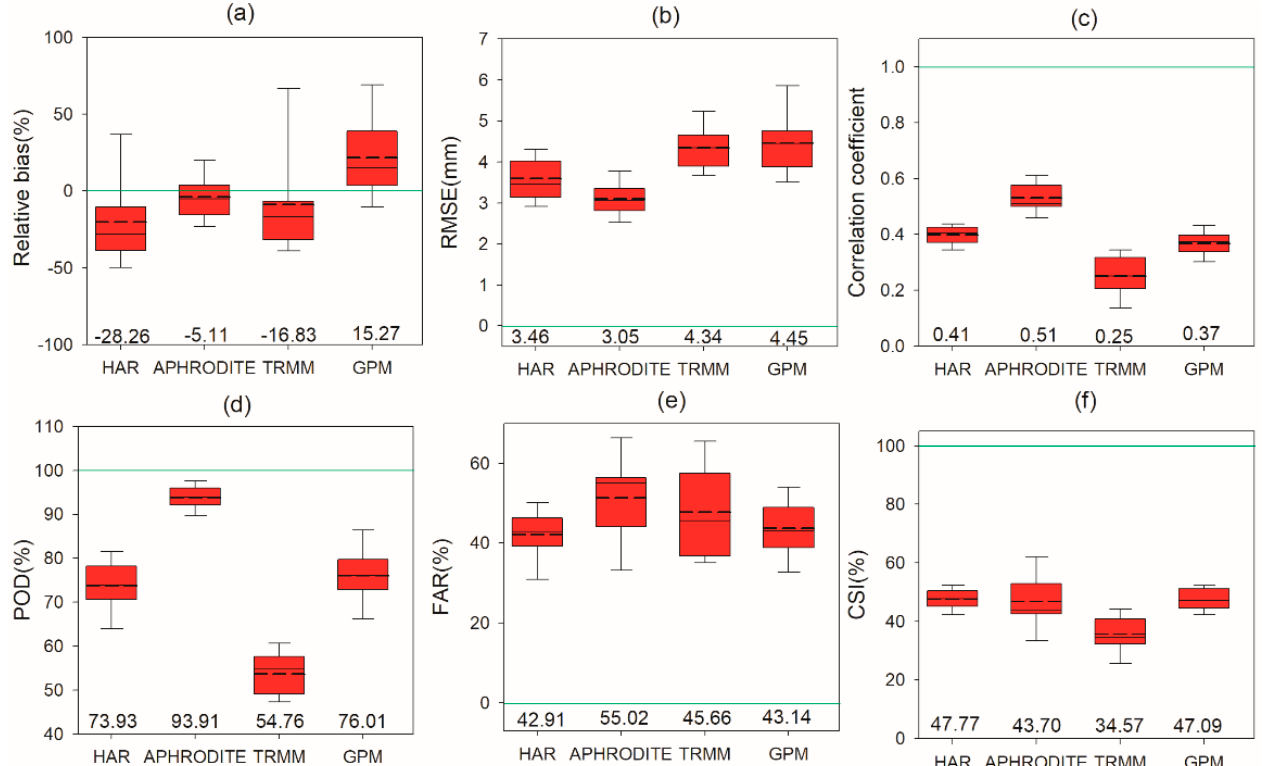
Figure 15. Box plots of 15 CMA stations-based statistical metrics over the UB at the grid scale: ( a ) RB, ( b ) RMSE, ( c ) CC, ( d ) POD, ( e ) FAR, and ( f ) CSI at daily scale for years 2001–2013. The number at the base of the box plot is the median value of each statistical metric. The short dash line in box plots denotes the mean value of statistical metric. The green horizontal line indicates the optimum value.